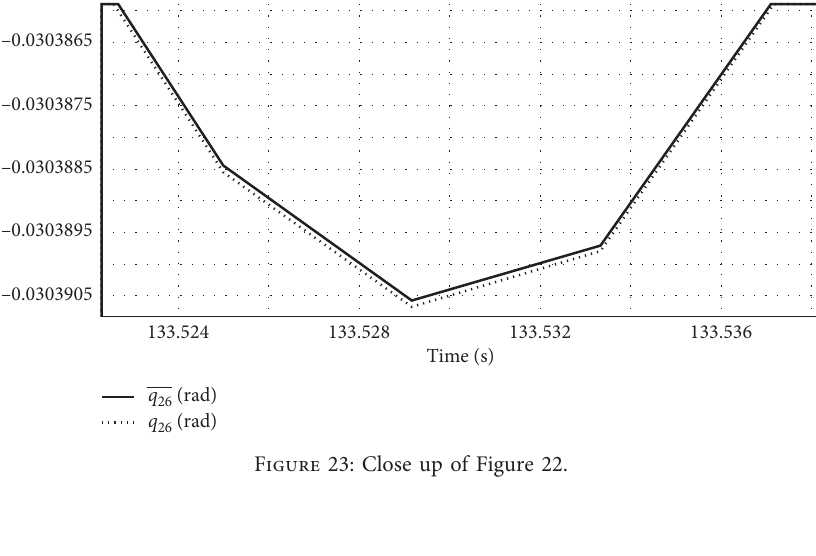
26 and the quasi-steady state model